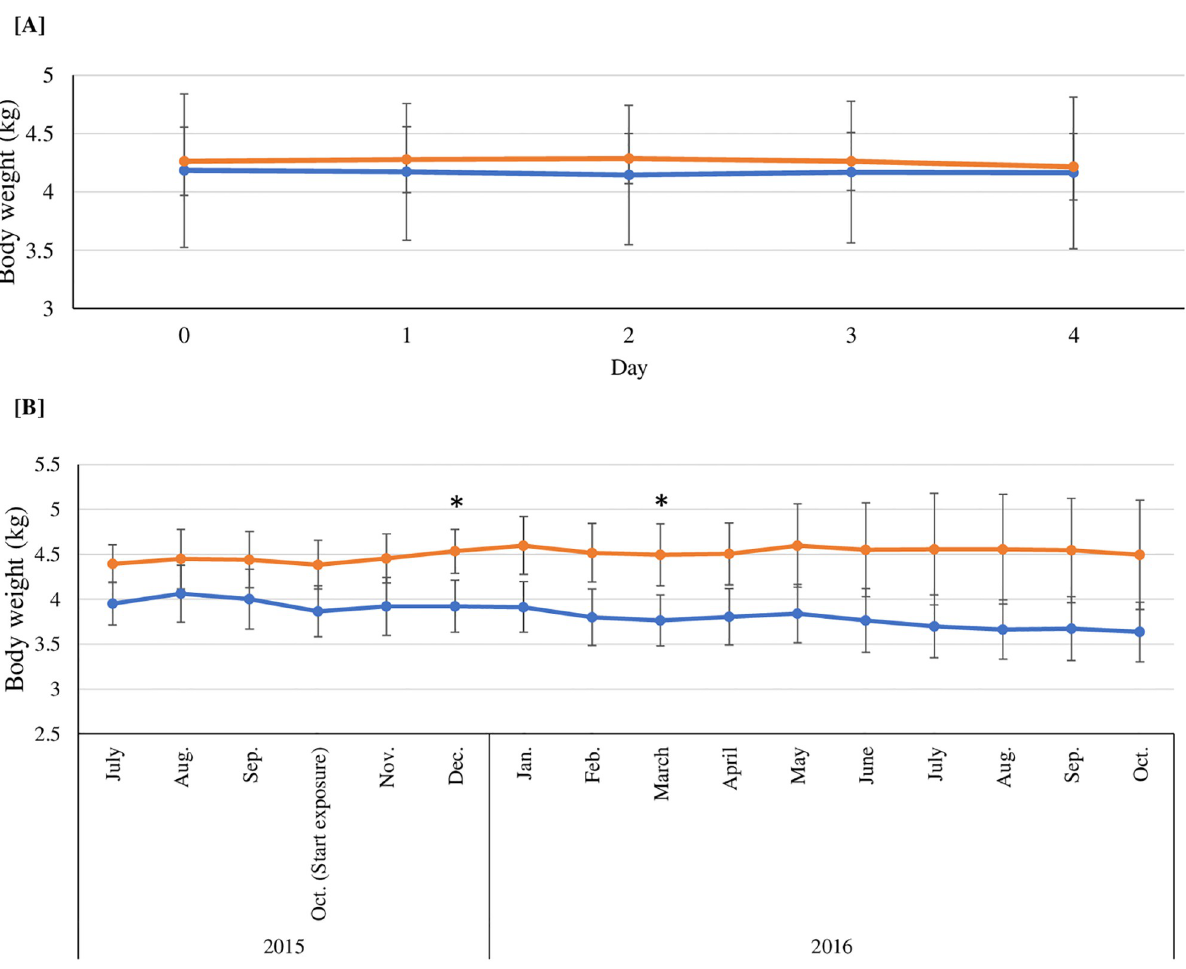
Fig 1. Time courses of body weight changes (mean ± SD) in time courses of the control (blue) and treatment (orange) groups for PCBs [A] and BDE-209 [B] ( � : Significant differences between two groups, P < 0.05).